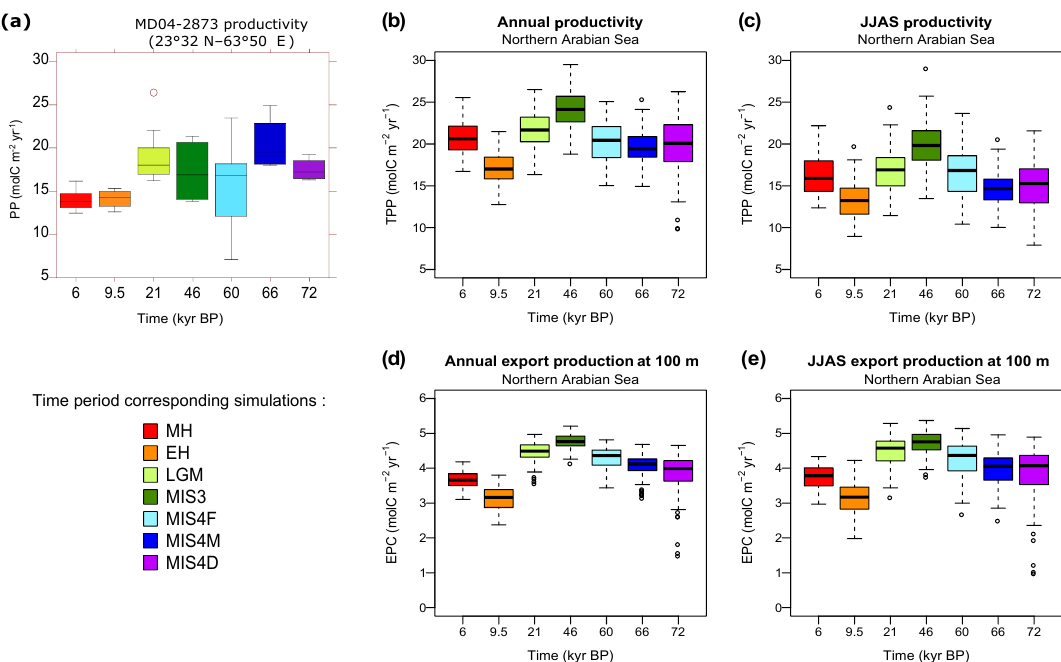
Figure 13. Box plots of (a) yearly reconstructed productivity from core MD04-2873 in the north-western Arabian Sea and (b) annual total primary productivity (TPP), (c) summer total primary productivity, (d) annual export production (EPC) at 100m and (e) summer export production at 100m in the northern Arabian Sea (60–68 ◦ E, 20–68 ◦ N) for the Holocene and glacial time periods. The box plots highlight the median value (bold line), the first and the third quartiles (lower and higher limits of the box), and the 95% confidence interval of the median (upper and lower horizontal dashes). The dots are extreme values that happened during the 100 years of simulation